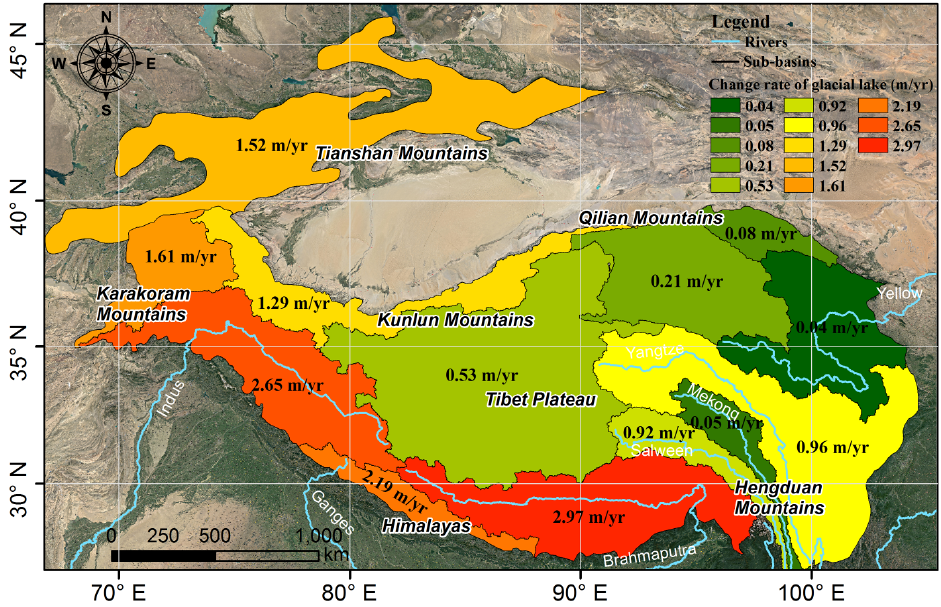
Figure 9. Mean rate of expansion of glacial lakes from 2008 to 2016 across the HMA region.